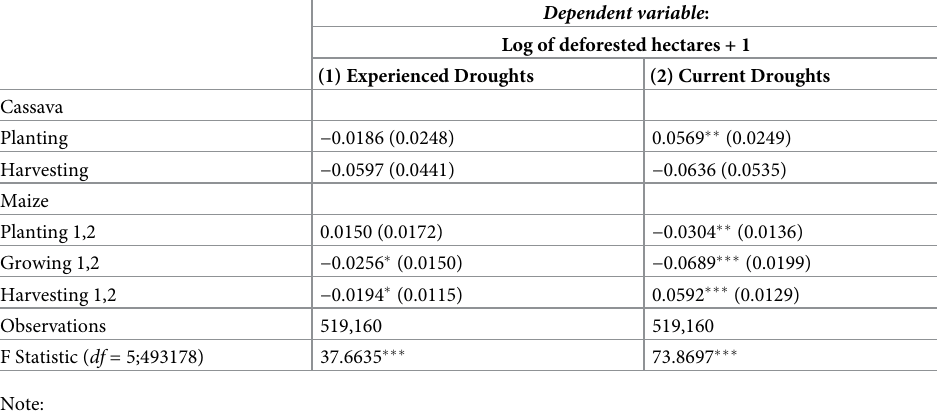
Table 1. Deforestation in response to experienced and current droughts. Analysis of cells characterized by at least 50% forest cover in the year 2000. The observations are then sampled to maintain the 35% of their total. Dependent variable